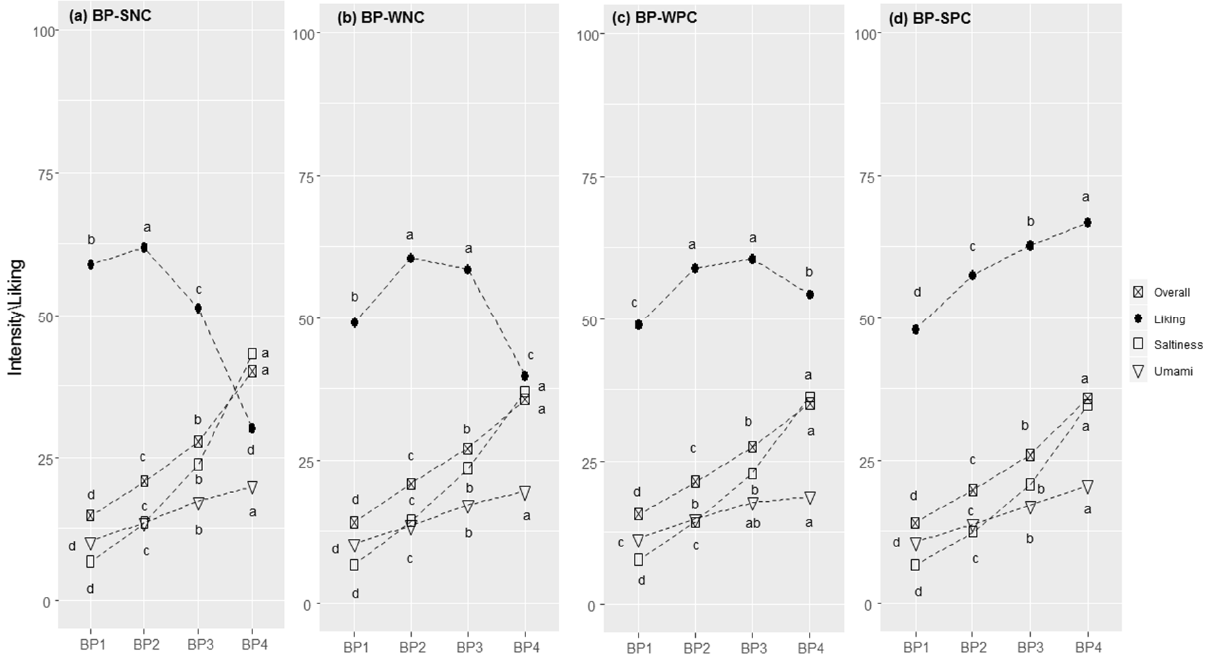
Figure 3. Bean pur é e (BP) responses in each cluster (SNC = Strong Negative Correlation ( a ), WNC = Weak Negative Correlation ( b ), WPC = Weak Positive Correlation ( c ), and SPC = Strong Positive Correlation ( d )): perceived intensity (gLM scale) and liking (LAM scale) for bean pur é e samples at increasing concentrations of sodium chloride (1–4). Within each cluster, different letters indicate significant differences in intensity/liking between concentration levels ( p <